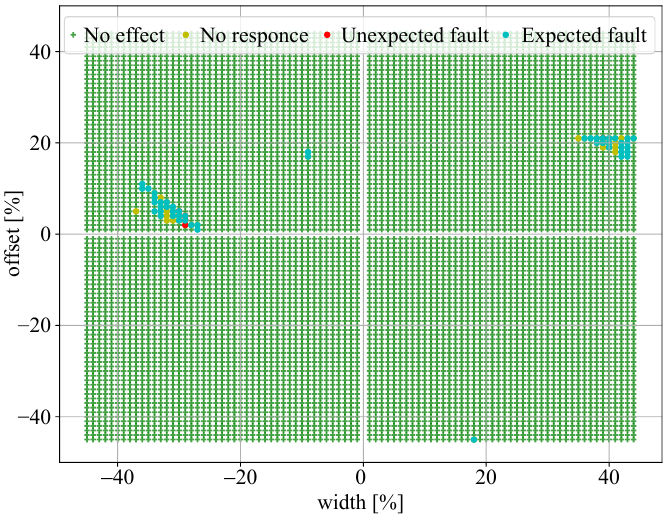
Figure 8: Characterization for searching proper glitch parameters. % represents ratio in percent of each parameter to the original clock